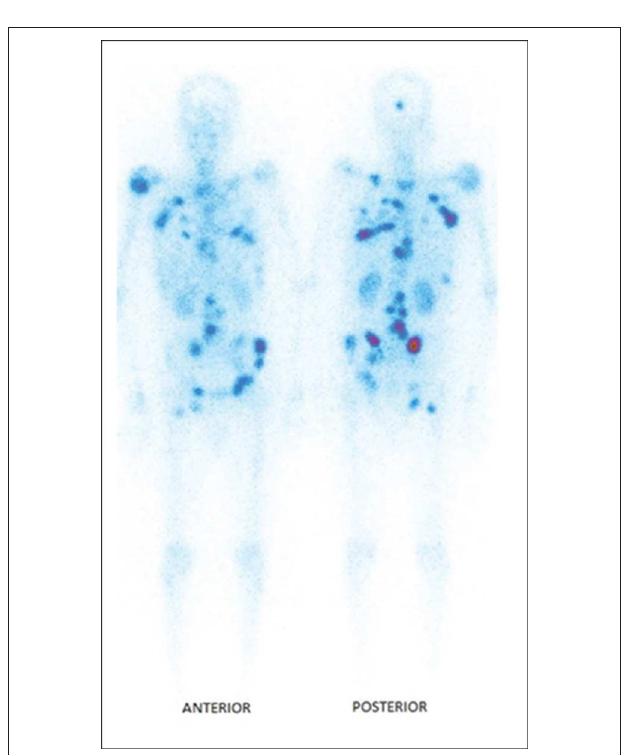
FIGURE 4 | Typical distribution of 188 Re-HEDP, 24h post-injection [from Shinto et al. ( 105), available under the terms of the Creative Commons Attribution-NonCommercial-ShareAlike License (CC